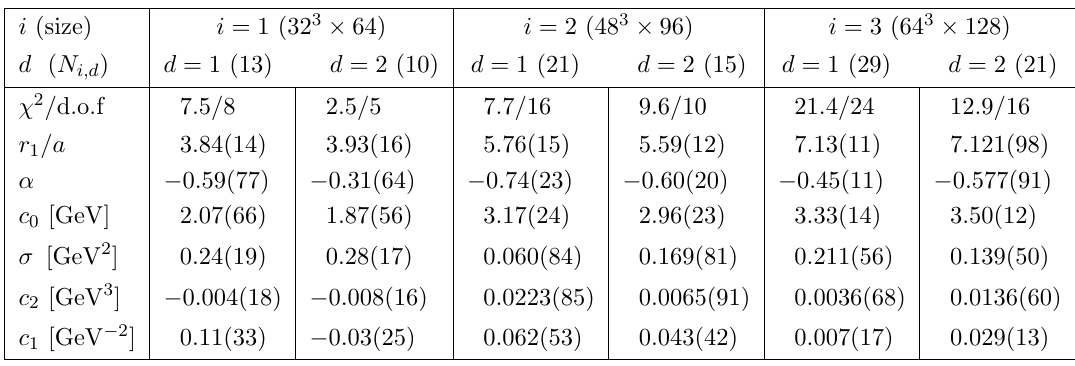
Table 2 . Fitting parameters in eq. (3.2), r 1 =a , and the reduced (cid:31) 2 . The (cid:12)tting parameters are shown as dimensionful quantities (except for (cid:11) ), which are originally obtained as dimensionless parameters normalized by proper powers of a . To make them dimensionful parameters, we use the lattice spacings estimated from the Wilson-(cid:13)ow scale. N i;d is the number of the lattice data used in